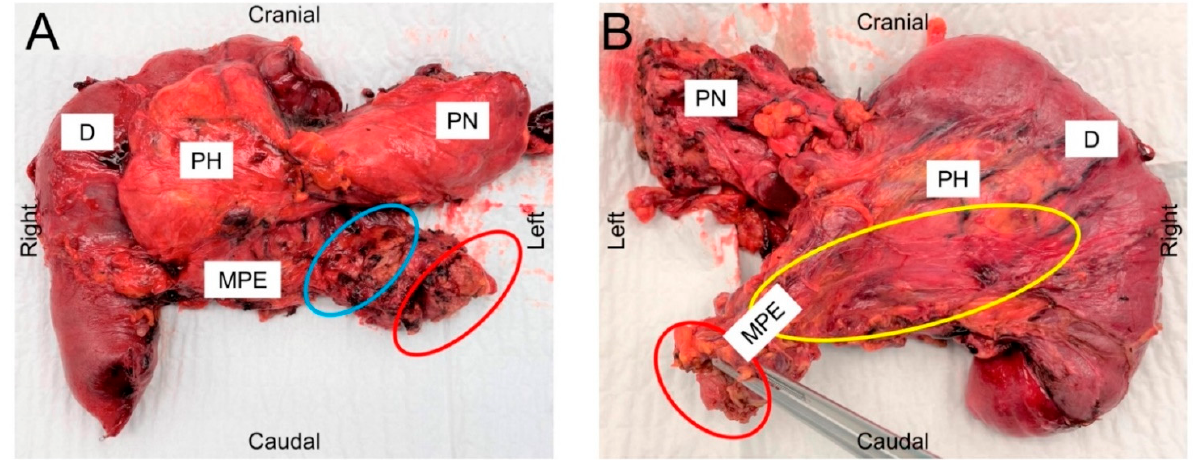
Figure 3. ( A ) Ventral view of specimen following pancreaticoduodenectomy for PDAC demonstrating mesopancreatic excision. ( B ) Posterior view of specimen. Note the fibrous tissue in B (yellow circle) extending between the mesenteric origin of the superior mesenteric artery and the duodenum. Positional markings indicate the position of specimen in situ. Red circle: pedicle of the mesopancreas arising from the SMA; blue circle: medial groove of the portal vein; yellow circle: Treitz fascia dissected and attached to the dorsal resection margin running up to the pedicle of the mesopancreas. (D: duodenum; MPE: mesopancreatic excision PH: pancreatic head; PN: pancreatic